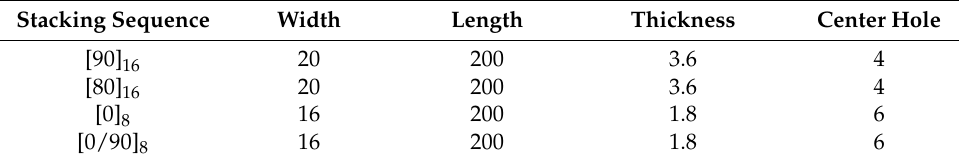
Table 2. Specifications of carbon-fiber-reinforced plastic specimens (mm).